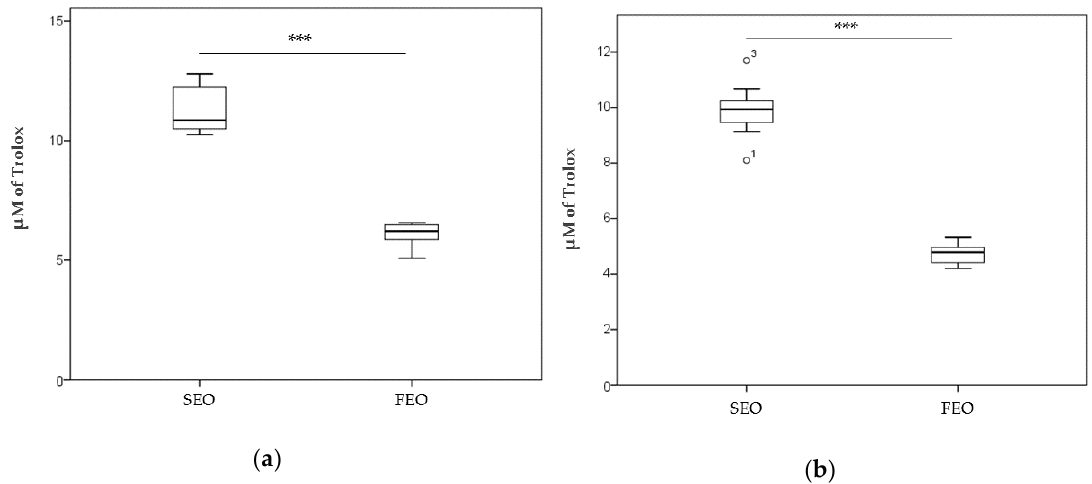
Figure 2. ( a ) Total antioxidant activity (TAA) measured in 2 mL of 2,2’-azinobis-(3-ethylbenz- thiazoline-6-sulfonic acid) (ABTS) solution in the presence of 20 µ L of SEO and FEO. The decrease in absorbance at 734 nm of ABTS solution is referred to a standard curve obtained by using known concentrations of Trolox. ( b ) Antioxidant activity versus DPPH radical was measured in 2 mL of DPPH solution in the presence of 50 µ L of SEO and FEO. The decrease in absorbance at 517 nm is referred to a standard curve obtained using known concentrations of Trolox ( µ M). *** p < 0.001. o 1 , o 3 : outliers values.